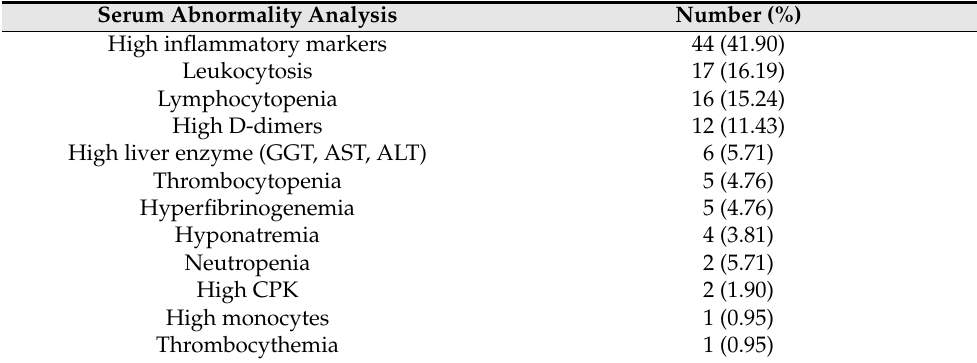
Table 6. Serum abnormality analysis.